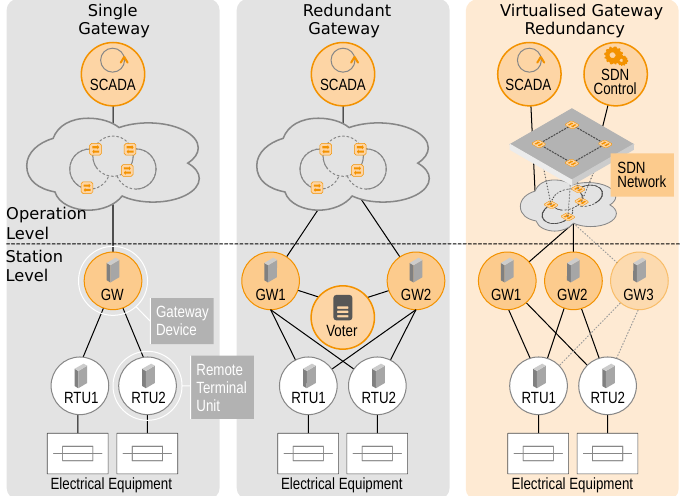
Figure 5. The virtualised gateway redundancy approach improves the flexibility of gateway redundancy implementations while additionally ensuring the separation of